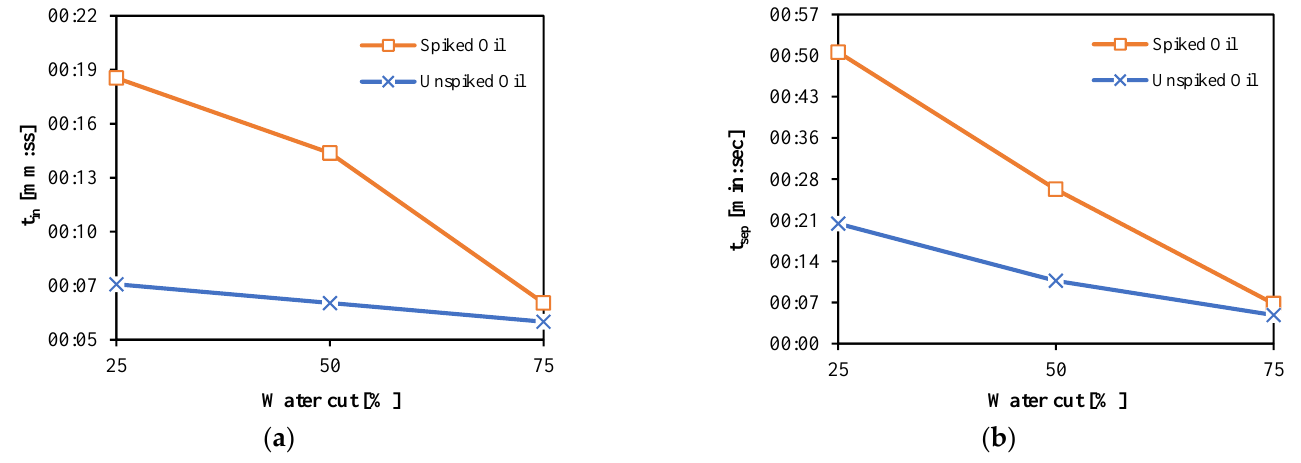
Figure 7. ( a ) Required time for fixed interface, t in , and ( b ) required time for phase separation, t sep versus water cut.